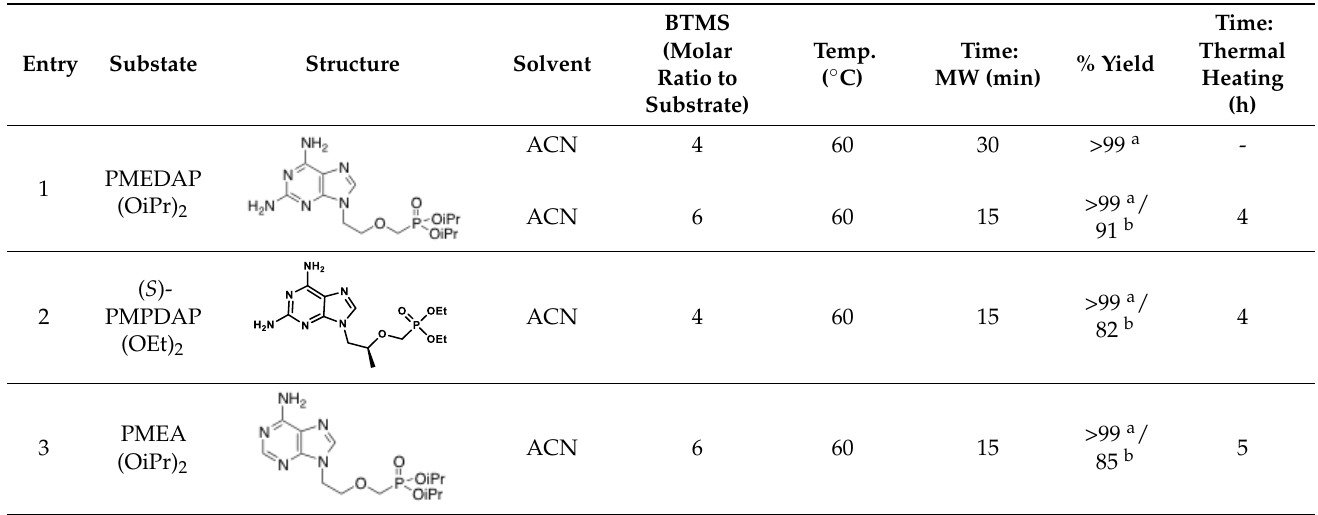
Table 3. BTMS dealkylations of acyclic nucleoside phosphonate esters using microwave irradiation.